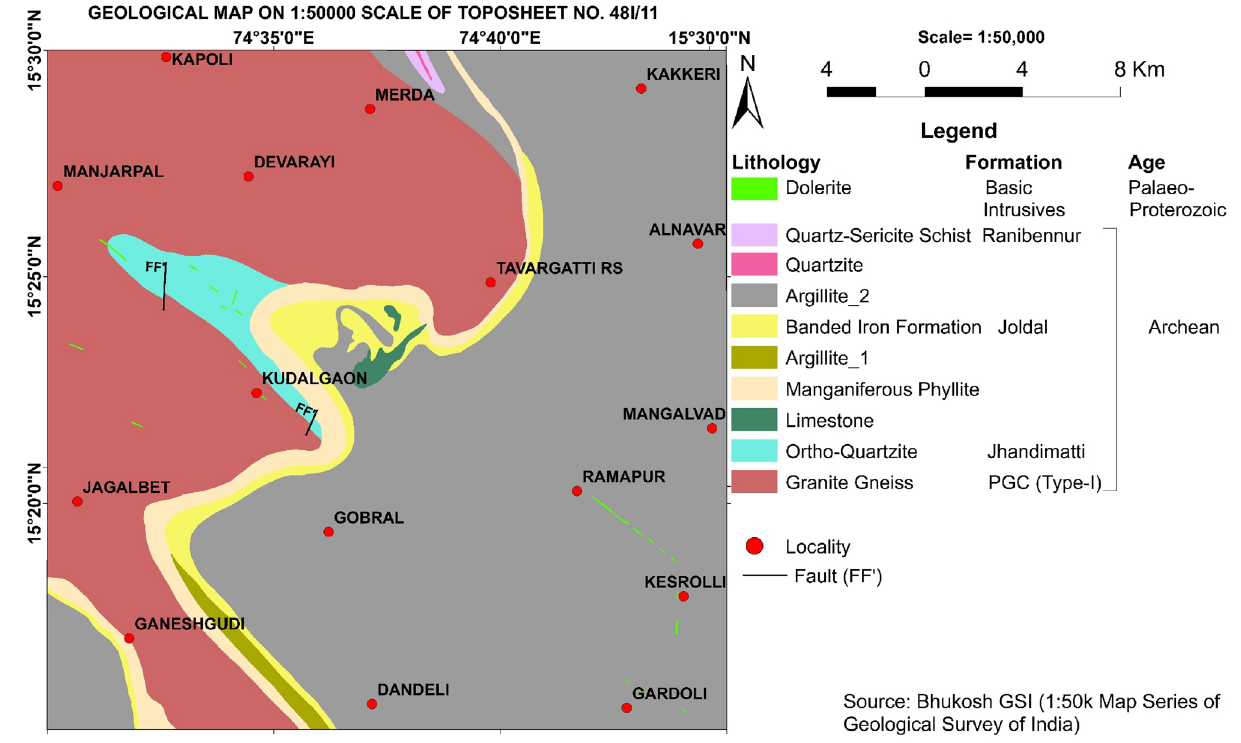
Figure 2. Geological map of the study area, Source: Bhat et al., 2021. Map prepared using Microsoft Paint and Origin-Pro 2016 software (URL link: http:// www. origi nlab.